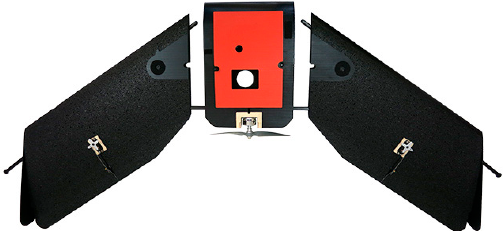
Figure 2. MicaSense RedEdge camera. It has five separate imaging sensors with specific optical filters to provide five spectral bands. The weight is 150g and the size is 12.1 × 6.6 × 4.6 cm (4.8” × 2.6” × 1.8”), so it is designed well for use on small unmanned aerial vehicles (UAVs). Images are captured at rate of 1 capture/s and stored in SD card.